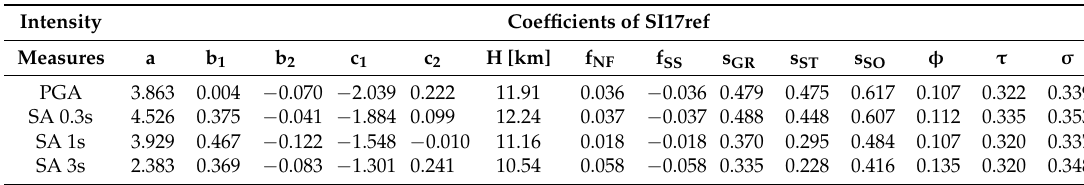
Table 3. Coefficients of SI17ref. PGA, peak ground acceleration; SA, 5% damping acceleration response spectra.